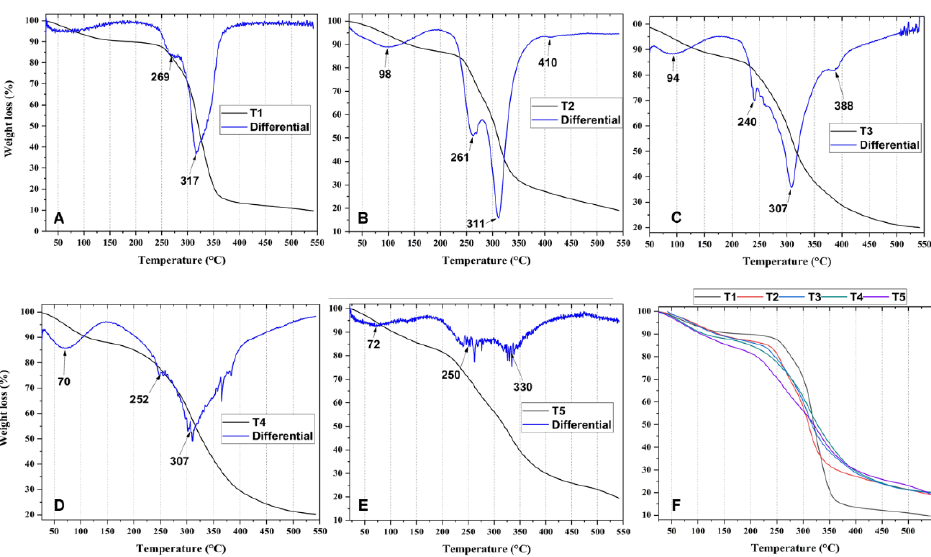
Figure 2. Thermogravimetric analysis for T1, ( A ) gelatin/cassava starch 0/100; T2, ( B ) gelatin/cassava starch 25/75; T3, ( C ) gelatin/cassava starch 50/50; T4, ( D ) gelatin/cassava starch 75/25; T5, ( E ) gelatin/cassava starch 100/0; ( F ) All the samples.